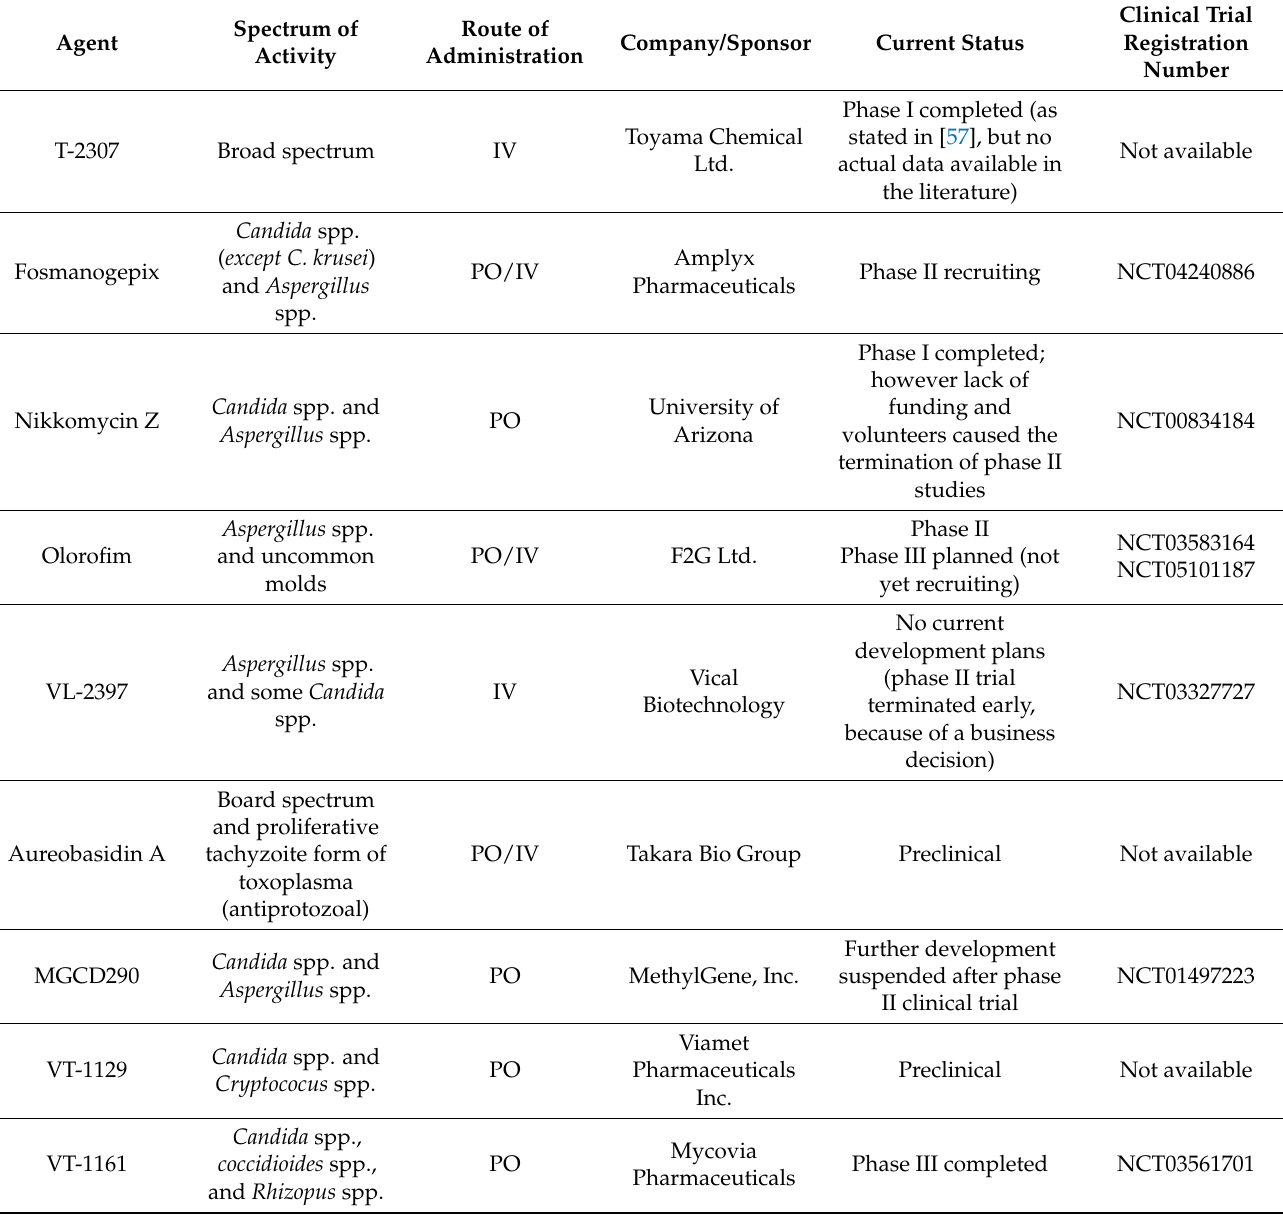
Table 1. The spectrum of activity, route of administration, production company, and current status of antifungals in clinical development. Clinical registration numbers were obtained from www.clinicaltrials.gov (accessed on 26 November 2021).